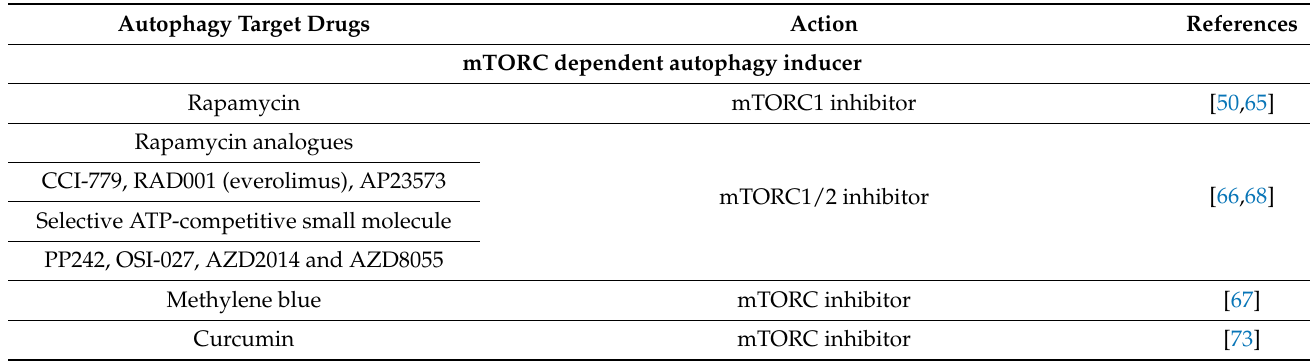
Table 1. Autophagy inducers that may be effective against Alzheimer’s disease. Abbreviations: mTORC: mechanis- tic target of rapamycin complex; AMPK: adenosine monophosphate-activated protein kinase; cAMP: cyclic adenosine monophosphate; IMPase: inositol monophosphatase; TFEB: transcription factor